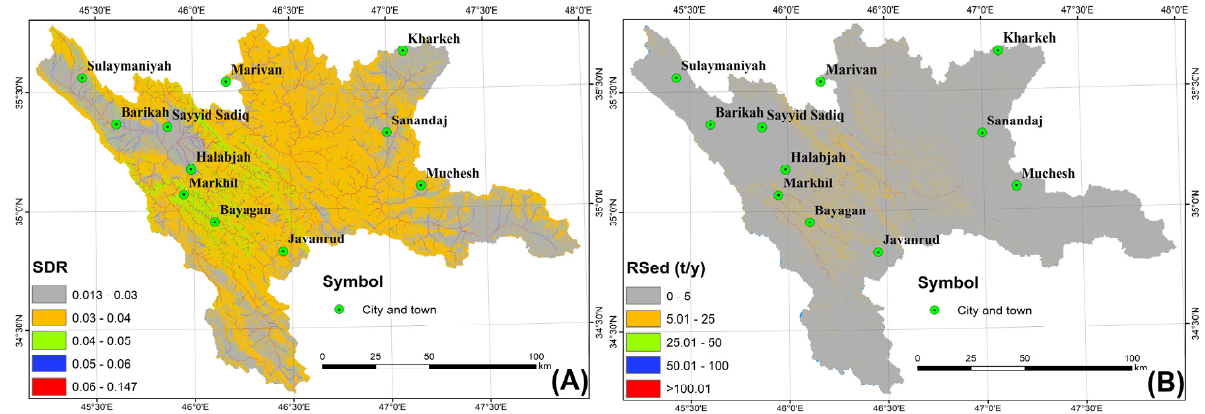
Figure 11. The distribution of the ( A ) sediment delivery ratio and ( B ) reservoir sedimentation maps within the DLB for the period until 2 May 2008.